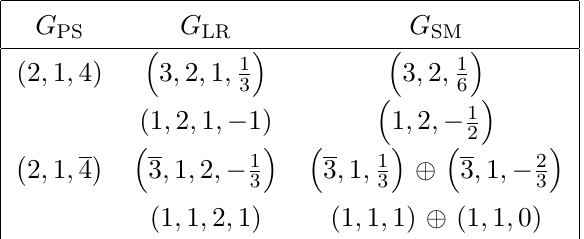
Table 7 . Decomposition for the representation 16 of SO(10) under G PS ≡ SU(2) L × SU(2) R × SU(4) , G SU(3) SU(2) SU(2) U(1) and the SM gauge group G c LR ≡ c × L × R × B − L SU(2) U(1) . L × Y